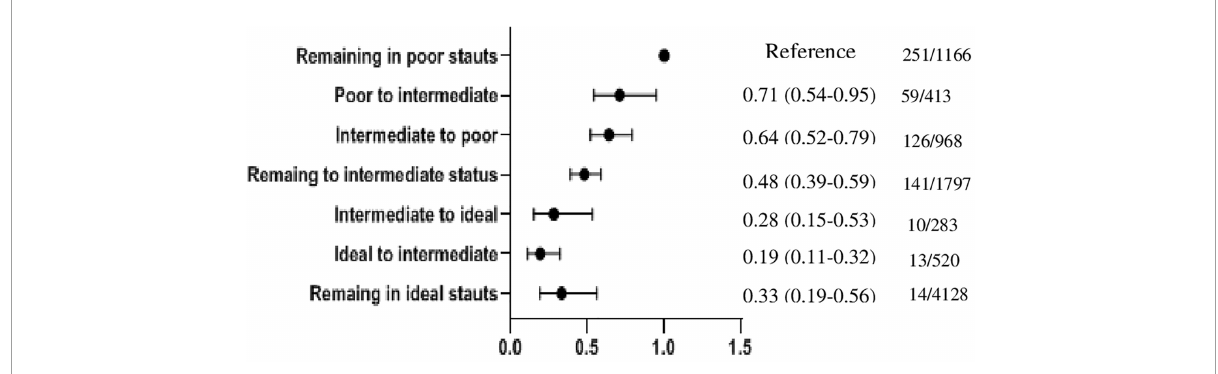
FIGURE2 Hazard ratios (95% CI) of cardiovascular disease according to the change in ideal CVH from phase III (2005–2008) to phase IV (2008–2011). n/N: the number of CVD events/the number of total subjects in each category. Because of the limited number of CVD events in poor to ideal ( n = 2) and ideal to poor ( n = 0) categories, the HRs (95% CI) were not computed.